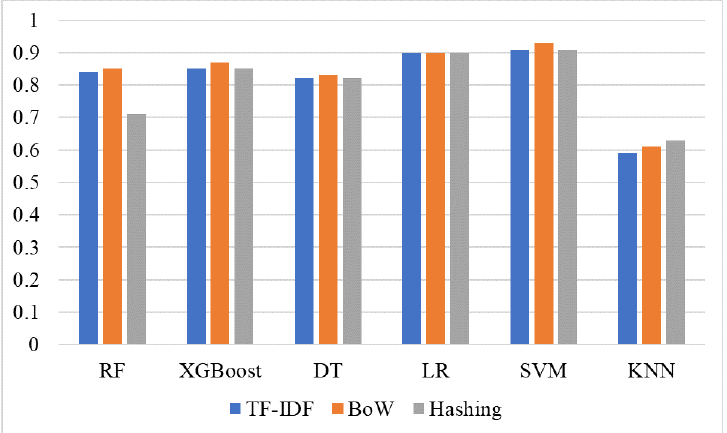
Figure 3. Comparison between model performances using BoW, TF-IDF, and hashing